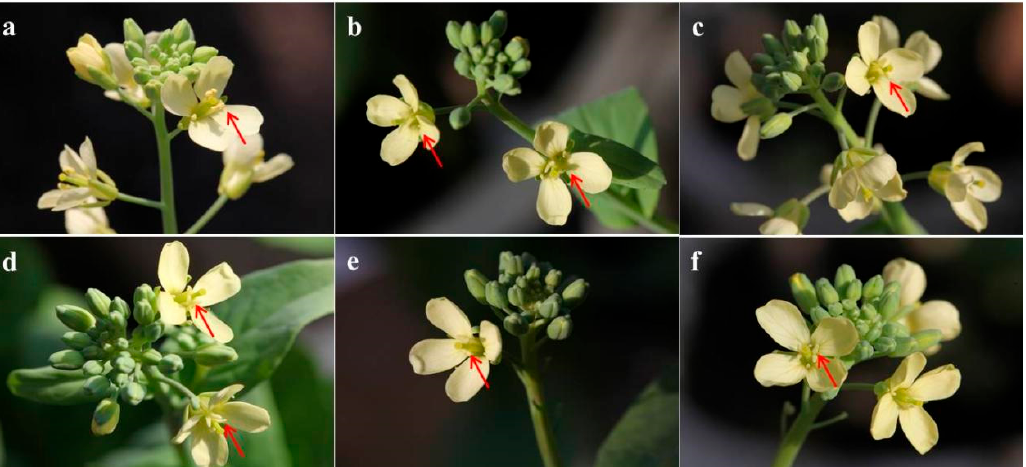
Figure 10. Five male-sterile mutants. ( a ) wild-type ‘FT’ plants; ( b – f ) male-sterile mutants. The red arrow points to the stamens.